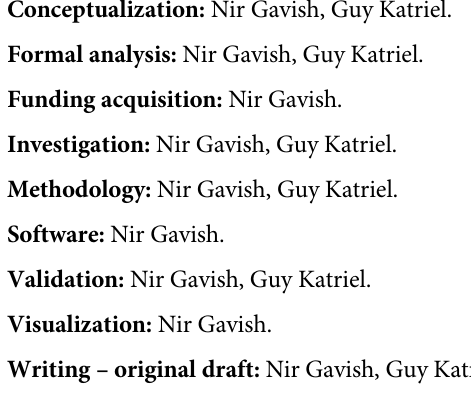
S11 Fig. Impact of preexisting immunity on vaccination coverage required for herd immu- nity. S12 Fig. Impact on preexisting immunity on critical reproduction numbers. S13 Fig. Pareto front with preexisting